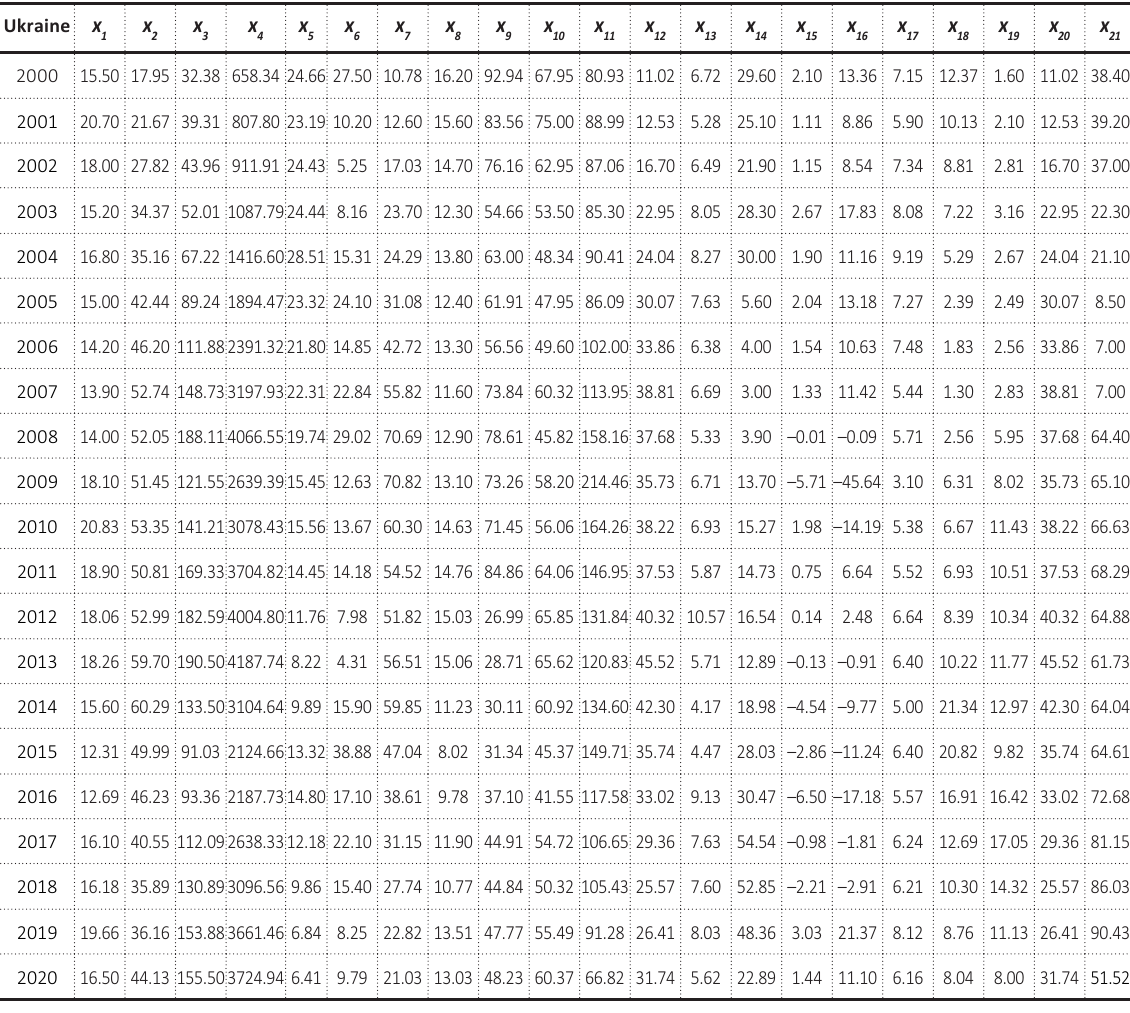
Table A1. Factors of influence on the efficiency of the Ukrainian banking system for 2000–2020 Ukraine x